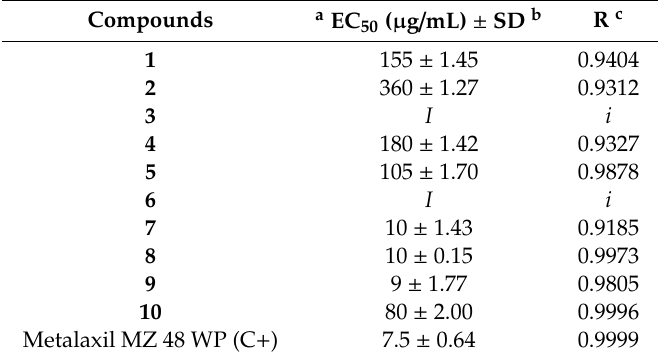
Table 1. EC 50 values of 2-AP and its synthetic derivatives on the in vitro mycelial growth of P. cinnamomi . These values were estimated by measuring the colony diameter after 144 h of incubation. Compounds